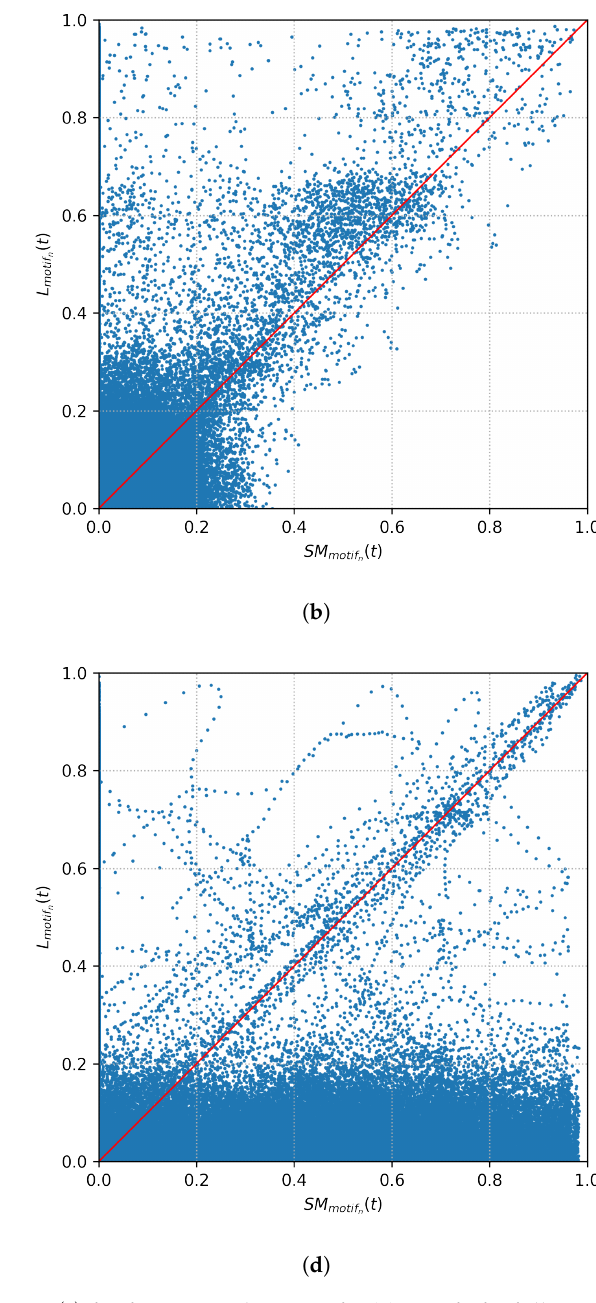
Figure 3. Scatter plot of correlations between L motif automatic coffee machine (’GeLaP’: household 05; device: 003). ( b ) Motif of a washing machine (’GeLaP’: household 05; device: 007). ( c ) Motif of a water pump (’GeLaP’: household 05; device: 008). ( d ) Motif of a television (’GeLaP’: household 05; device: